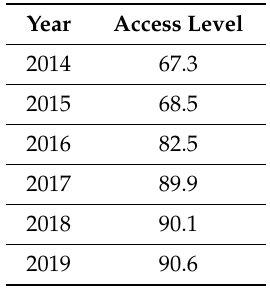
Table 2. Access Level of older people by year.